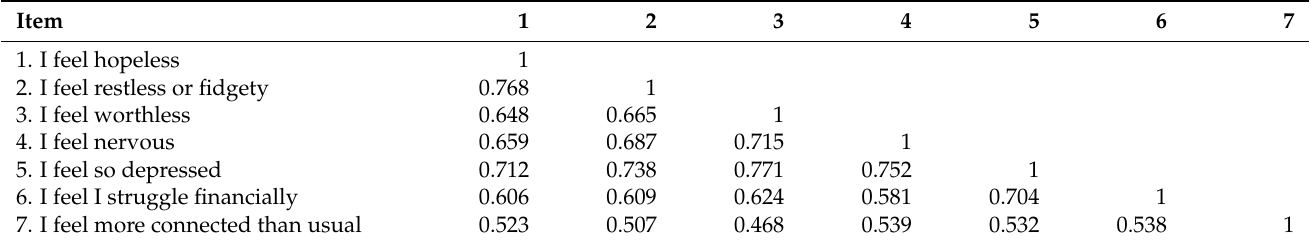
Table 1. Inter-item correlation of emotional self-efficacy among Chinese respondents.